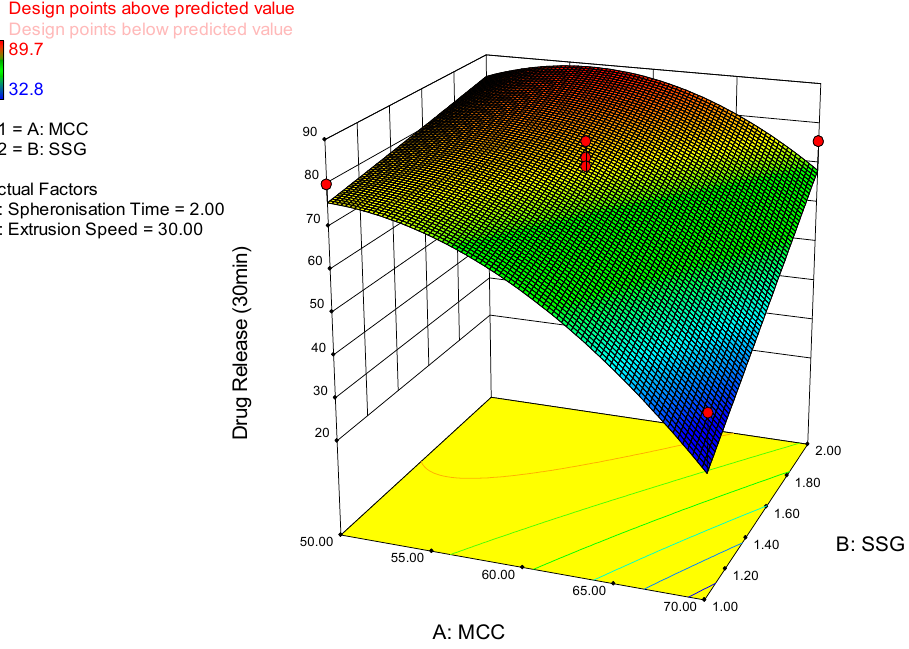
Figure 1. 3D response surface plot depicting the impact of microcrystalline cellulose and sodium starch glycolate concentration on prednisone release at 30 min.